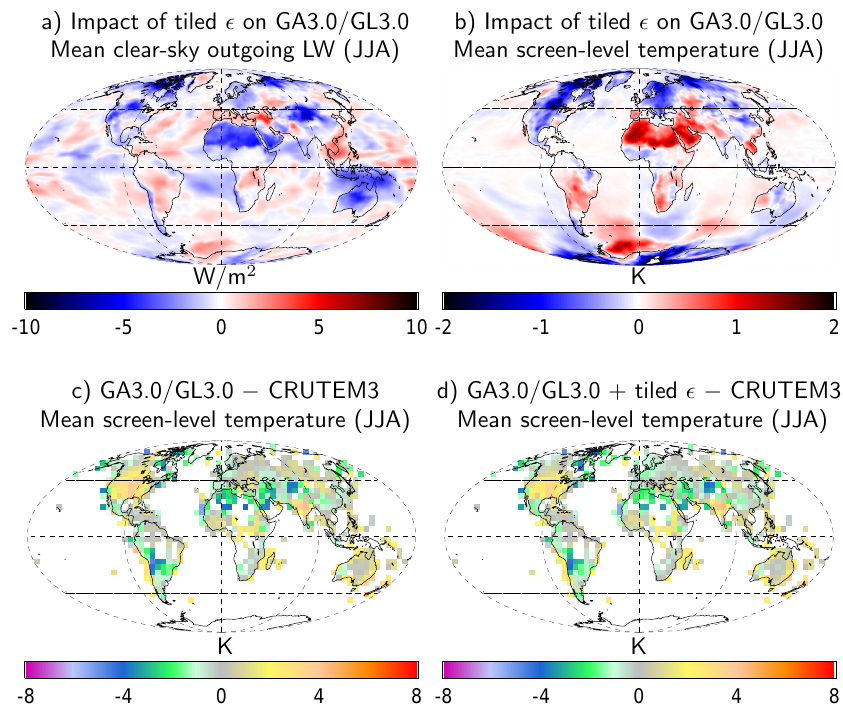
Fig. 4. Impact of the tiled emissivity ǫ on (a) the mean clear-sky outgoing LW radiation and (b) the mean screen-level temperature during JJA in a 10 yr N96 atmosphere/land-only climate simulation as well as the screen-level temperature errors in (c) the control simulation and (d) the test simulation against the CRUTEM3 climatology (Brohan et al., 2006). used in GA4.0 (in height coordinates), which was chosen